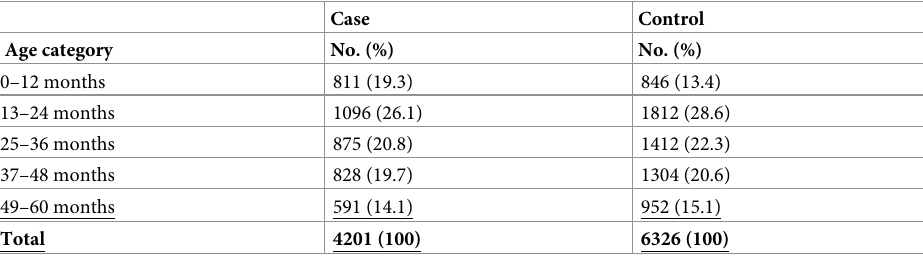
Table 1. Age distribution of patients, both cases and